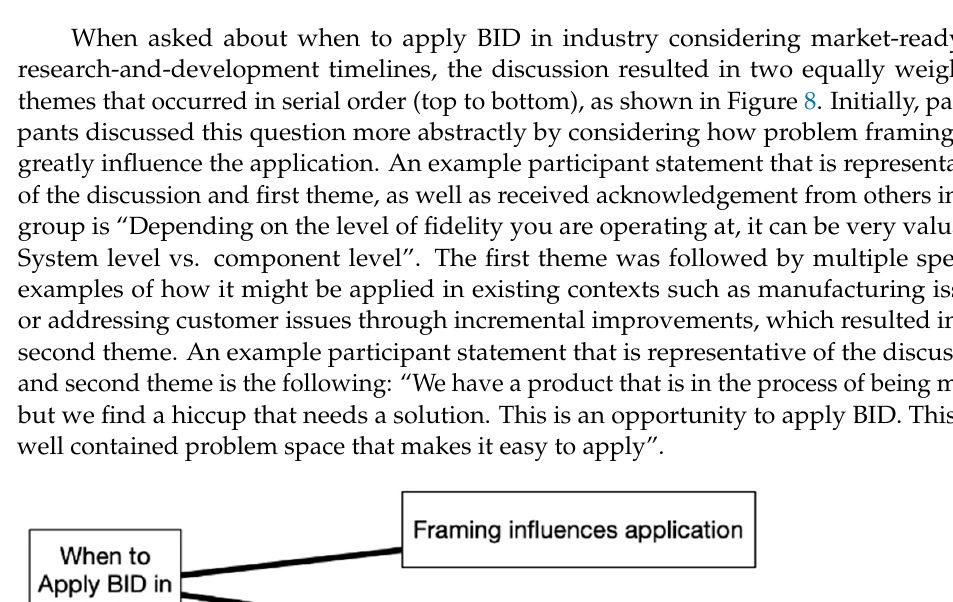
Figure 7. Talk to biologist discussion themes.